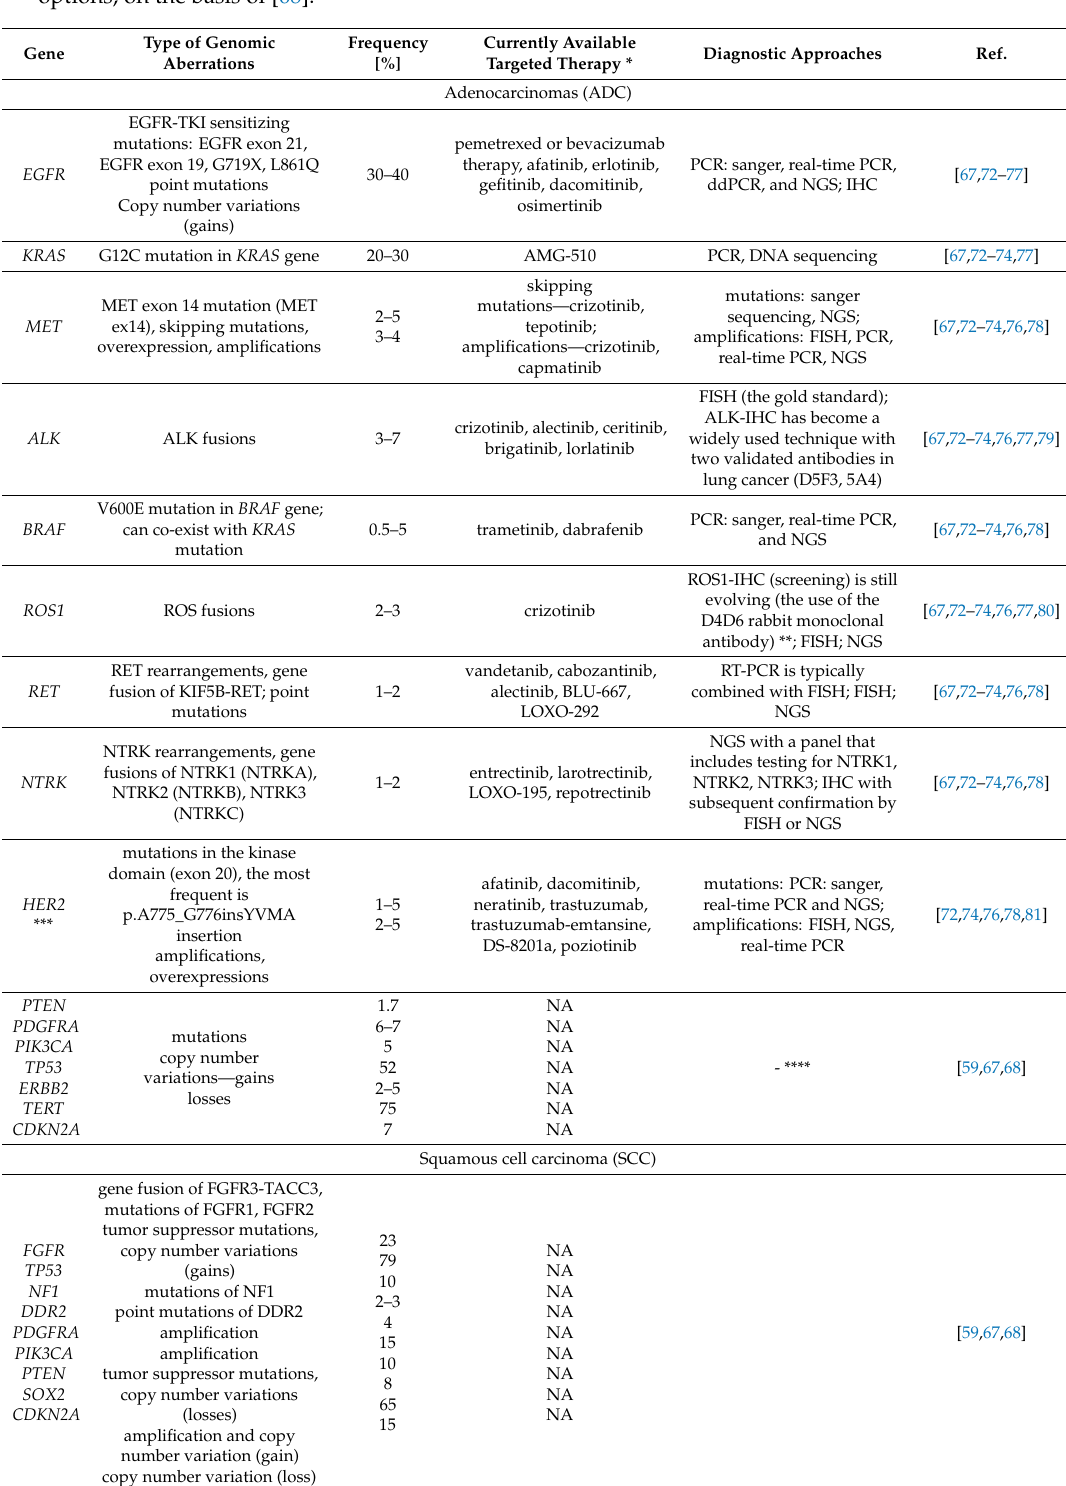
Table 3. Molecular landscape of non-small cell lung carcinoma (NSCLC) with the available treatment options, on the basis of